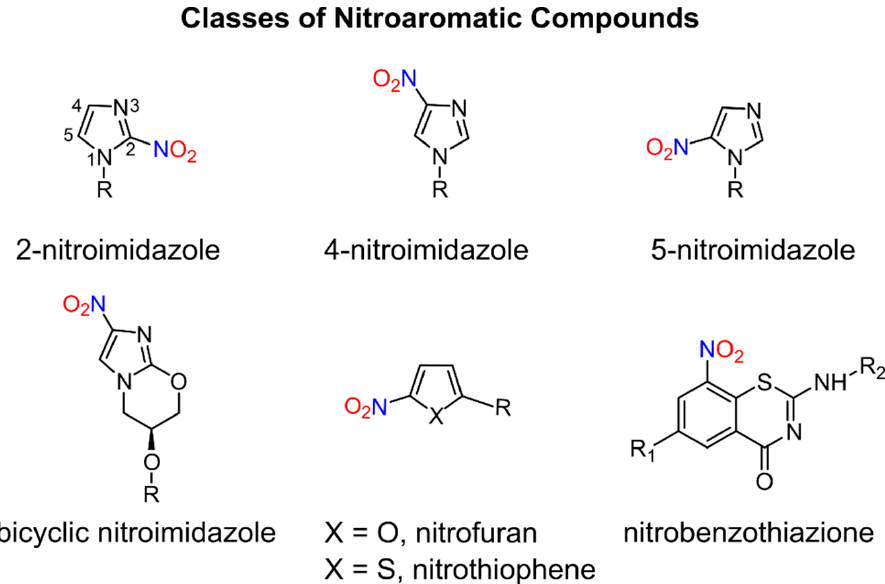
Figure 1. General classes of biologically active nitroaromatic compounds.